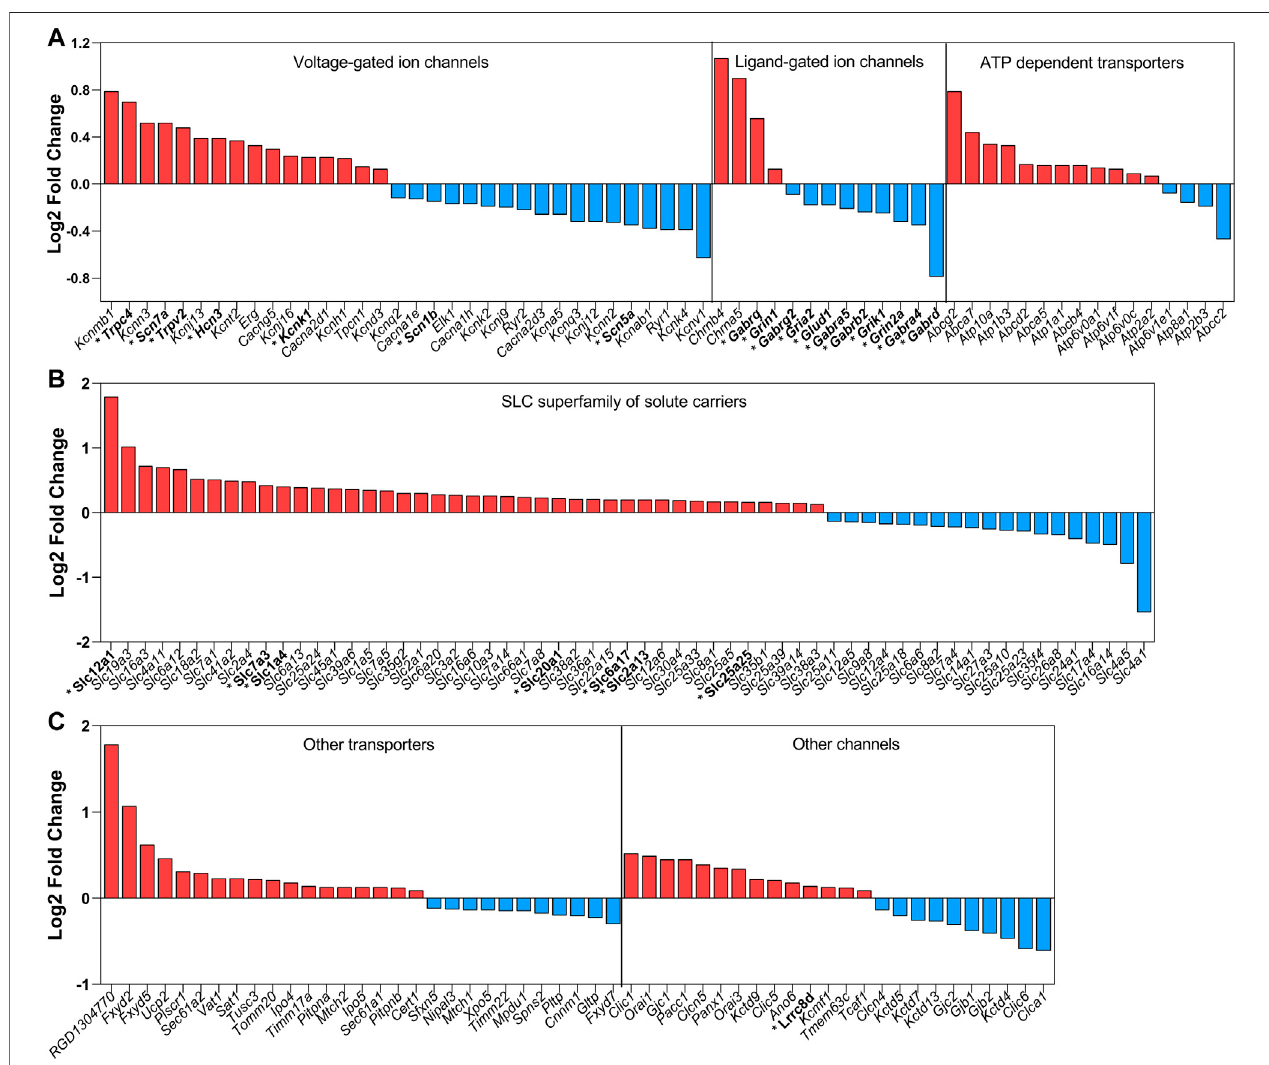
FIGURE 1 | Summary of the mRNA coding channels and transporters found to be changed by water deprivation for 3 days. Data obtained with the RNAseq approach by Pau ž a et al. (2021). In red are the upregulated mRNAs and in blue are the downregulated mRNAs. In this global analysis, we found coding mRNAs signi fi cantlyanddifferentiallyregulatedfor34voltage-gatedchannels(16upand18down),13ligand-gatedionchannels(4upand9down),24otherionchannels(14up and 10 down), 61 SLC superfamily of solute carriers (42 up and 19 down) and 29 of other transporters (18 up and 11 down). The mRNAs coding channels and transporters that we discuss in the present review are highlighted with an asterisk and in bold.